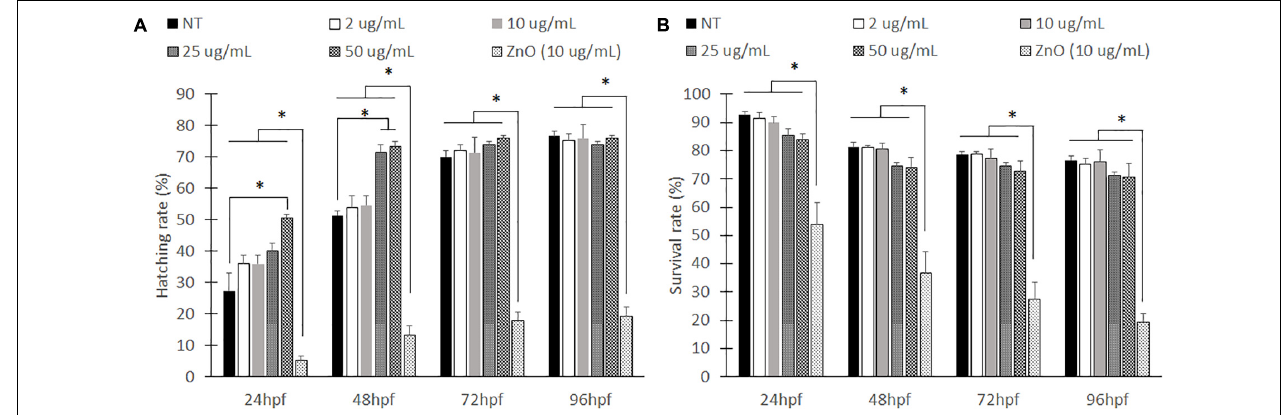
FIGURE 1 | Hatching rates and survival rate for embryonic zebrafish toxicity study. Hatched to unhatched ratio (A) and survival rate (B) of non-treated fish to various concentrations of empty PLGA nanoparticle suspension. *indicates a significant difference ( p < 0.01). n = 50 fish per group.